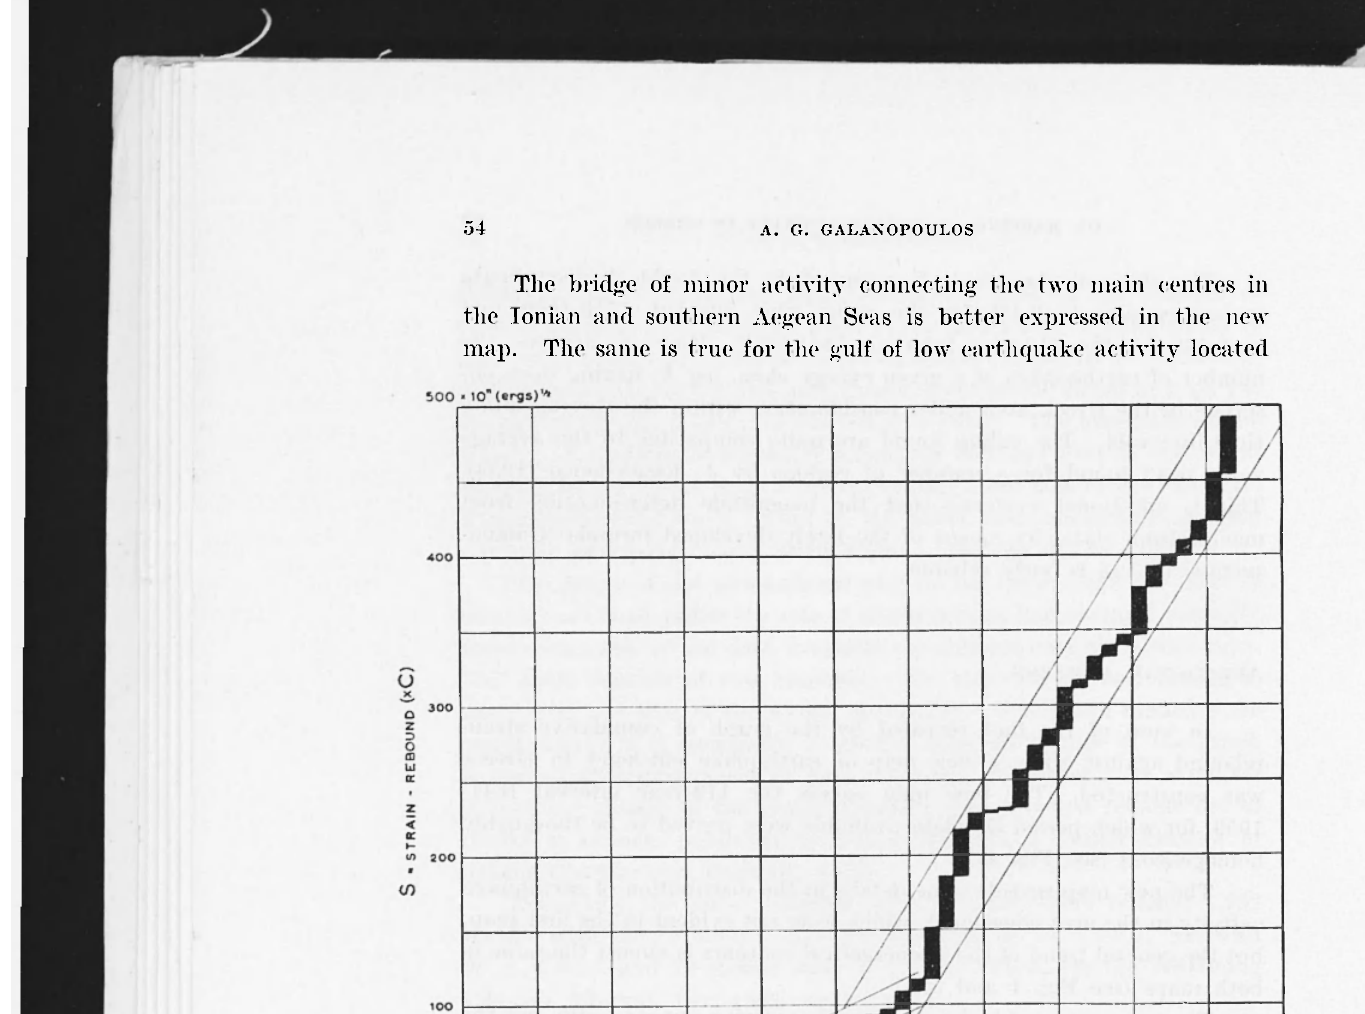
Fig. 4 - Rate of strain release for ali earthquakes of magnitude > 4 3 / 4 occurred ili the Greek area bounded by the parallels of 34° N and 42" N and tlie meridians of 19° E and 29° E during the period